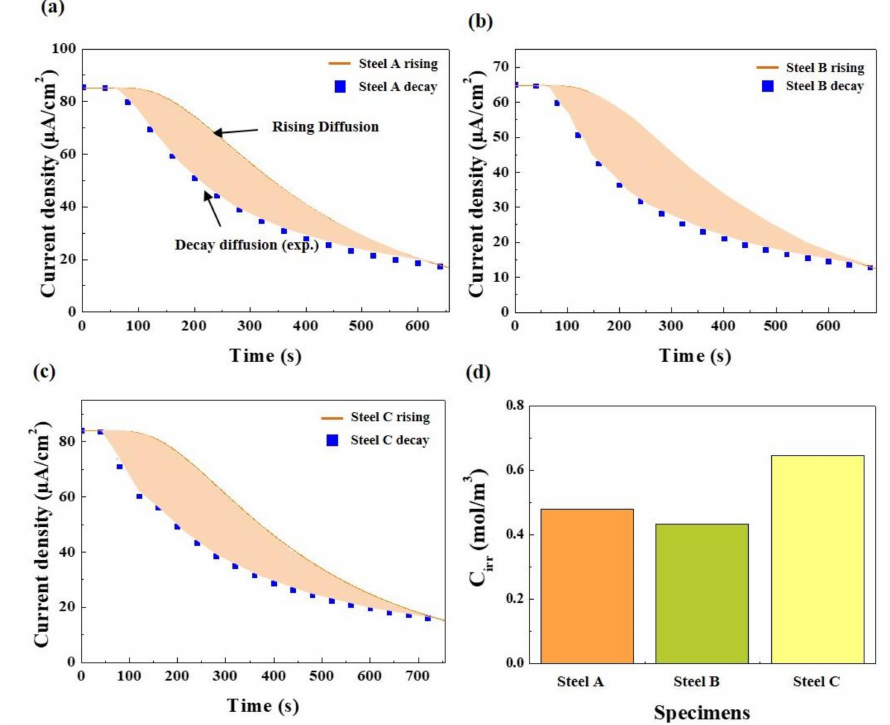
Figure 7. Irreversibly trapped hydrogen contents measured by the area between the two fitted decay transients: ( a ) Steel A, ( b ) Steel B, and ( c ) Steel C, and ( d ) bar chart of the irreversibly trapped hydrogen contents of the three steel